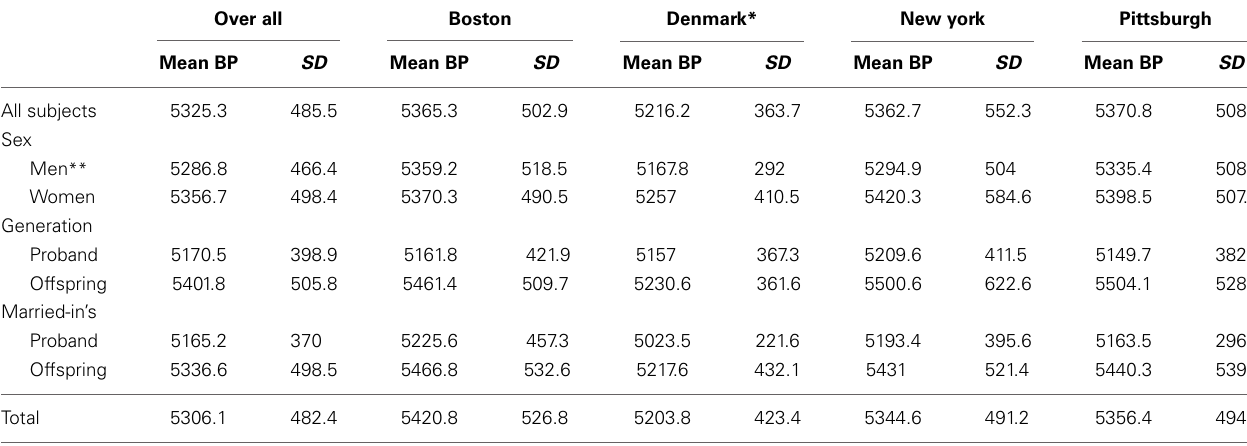
Table 2 | Mean leukocyte telomere length by site and by sex and generation. Over all